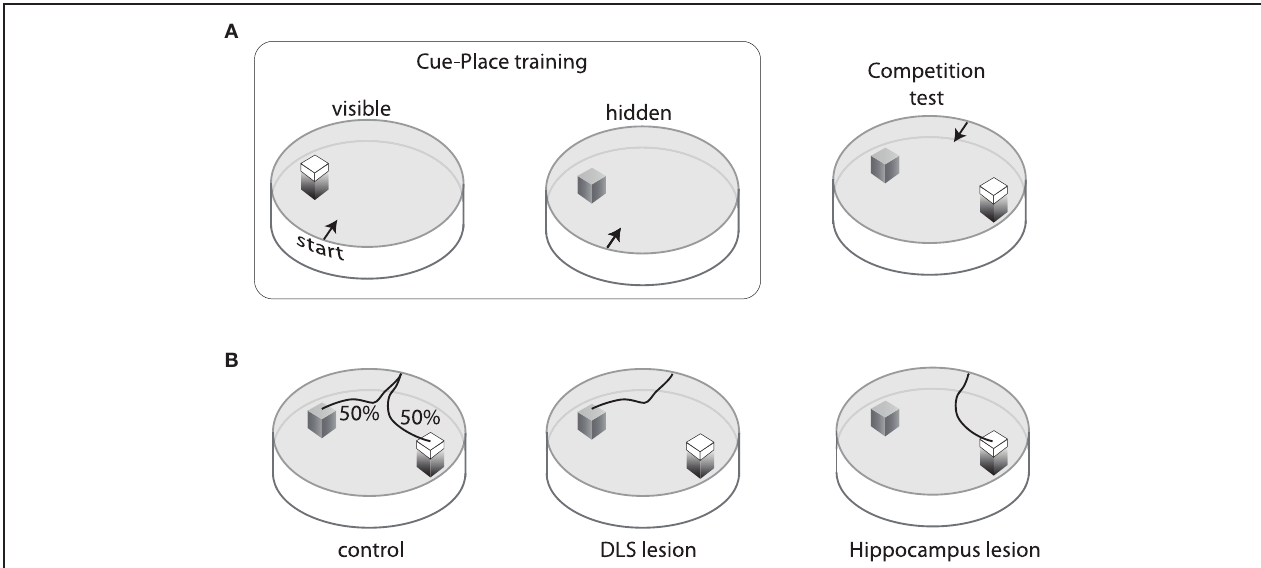
which the visible platform is moved to a new location in the pool and the invisible platform remains in the original position. Rats start from one of two points equidistant from the platforms. (B) On this competition test, control rats are equally likely to choose either the cue or the place response. Rats with neurotoxic damage to the hippocampus mainly swim to the visible platform, whereas those with neurotoxic damage to the dorsolateral striatum mainly swim to the invisible